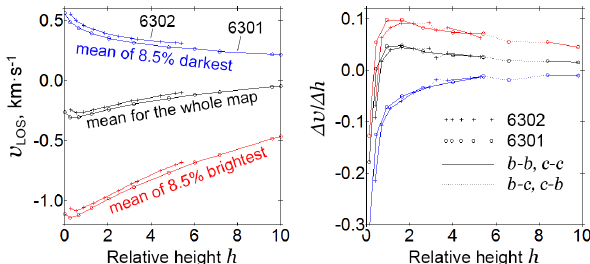
Figure 7. Left: Averaged (mean) v LOS versus relative height h for >140000 points of maps. Red and blue graphs – the data for >12000 points of respectively brightest ( I > 1.145) and darkest ( I < 0.94) C C points. Right : Correspondent averaged ∆v LOS / ∆h values. We see that the combination of levels for which the velocities were de- termined in different ways ( b and c ), generates steps on the right